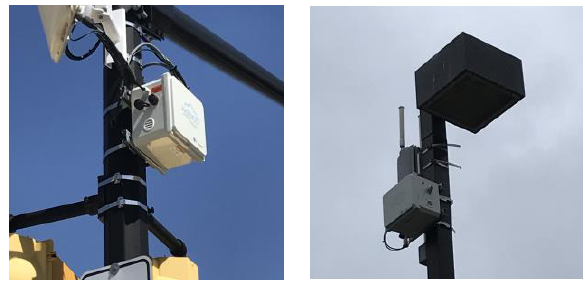
Figure 1. AirSENCE™ units in the GTA Satellite Smart